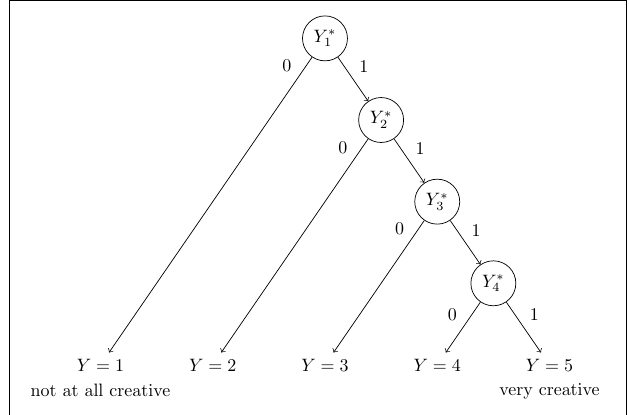
FIGURE 1 | Linear response tree for the creative quality ratings. The Y ∗ r represent sub-items (De Boeck and Partchev, 2012) and the Y the response categories for the